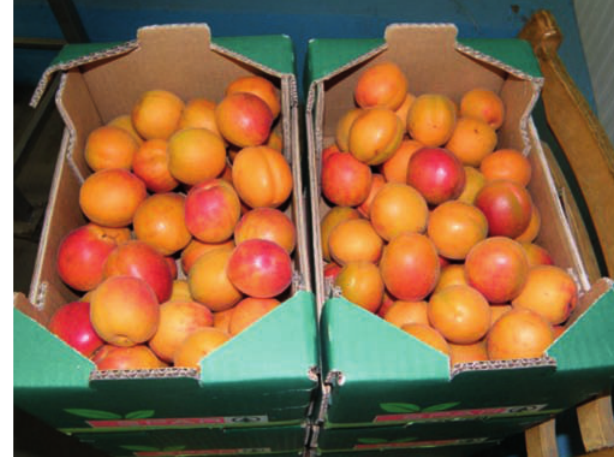
Fig. 10: 2.3 kg fruit in a carton box